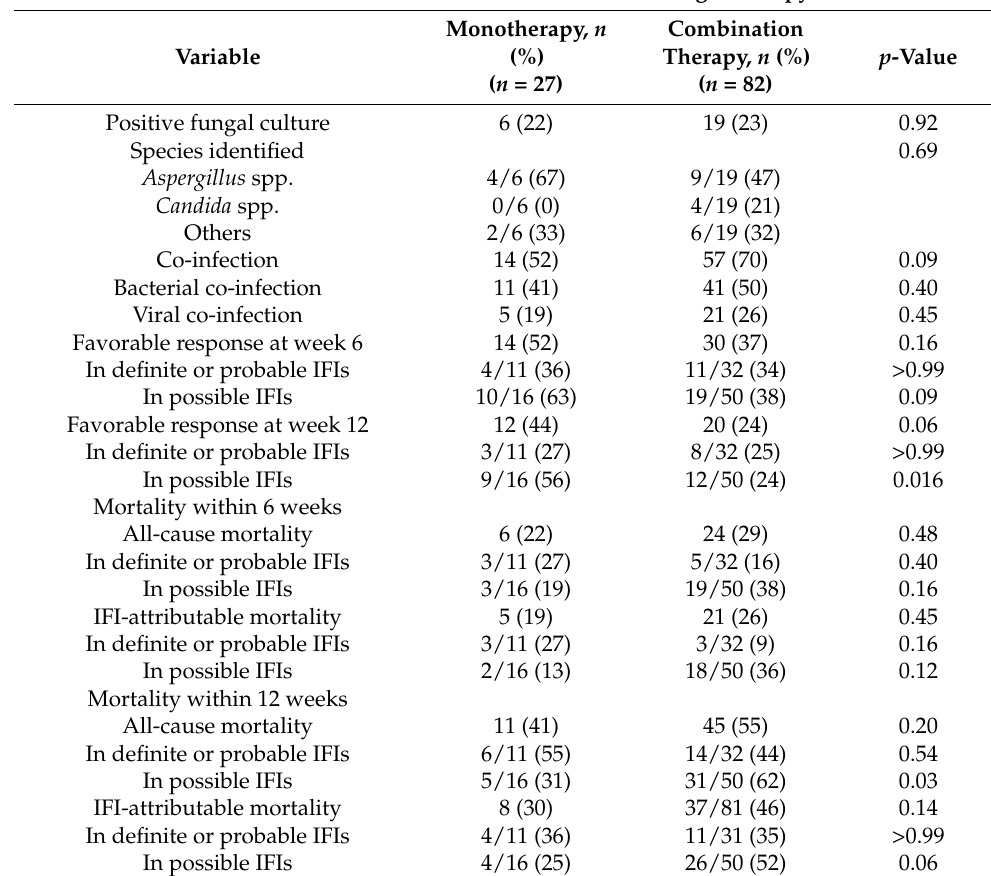
Table 2. Cont. (B) Patients Who Switched to Isavuconazole Salvage Therapy